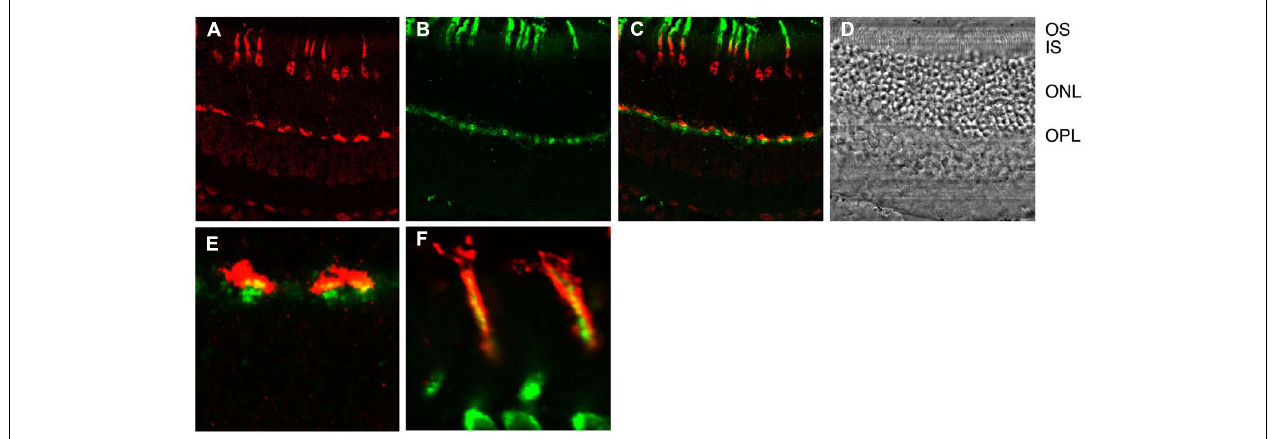
FIGURE 3 | Immunhistochemical localization of S100B to cones in the murine retina. (A) Cone arrestin in red. Cone outer segment labeling is overshadowed with by strong labeling of the synapse, nucleus and inner segment. (B) S100B in green. Selected outer segments are labeled intensely. Inner segments and synapses are also labeled. (C) Composite showing that cone arrestin and S100B labeling are restricted to cones. (D) Bright field. OS, outer segments; IS, inner segments; ONL, outer nuclear layer containing nuclei of rods and cones; OPL, outer plexiform